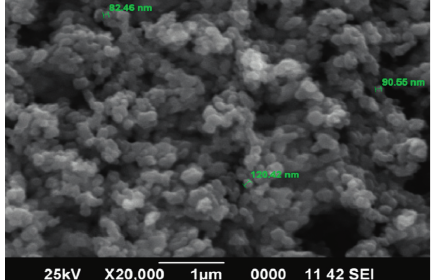
Figure 2: The SEM image of ZnO